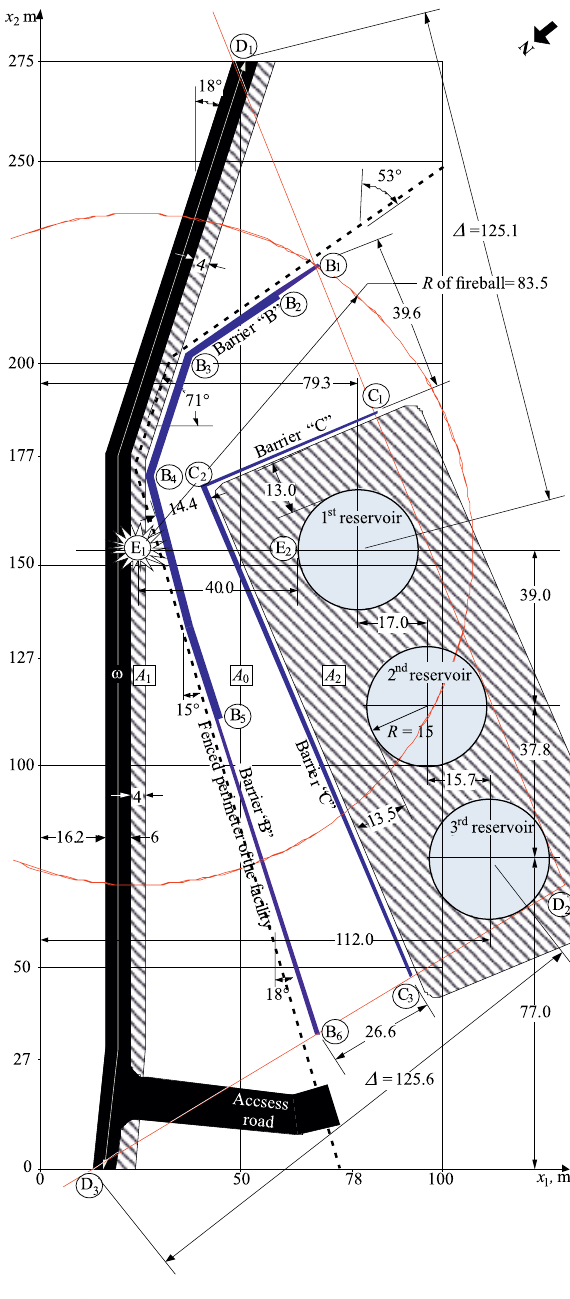
Fig. 5. The situation of a potential explosion on road and a roadside object to be protected by a safety